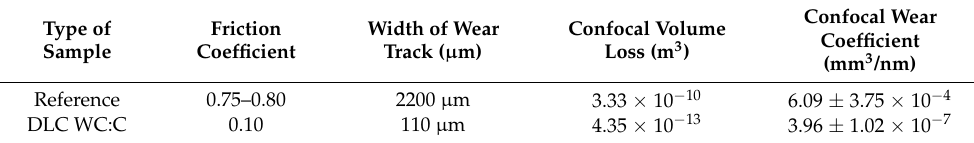
Table 5. Summary of the experimental data for the volume loss and wear coefficient measured by confocal microscope for the reference sample and DLC WC:C